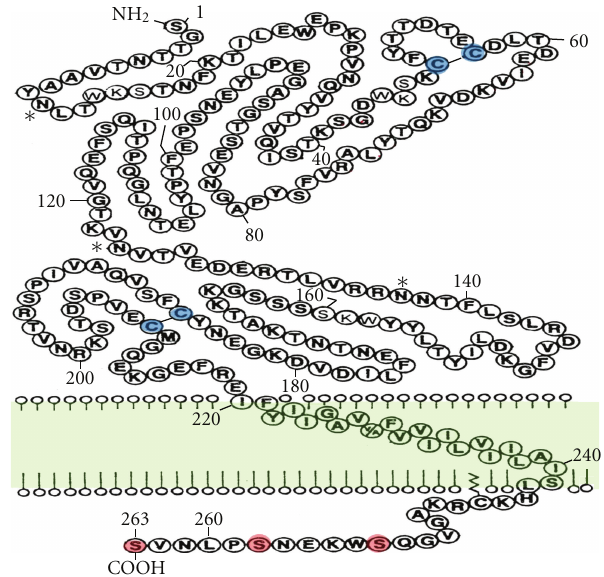
Figure 1: TF structure. The 46-kDa membrane-bound single polypeptide chain consists of extracellular, transmembrane, and cytoplasmic domains. There are 2 intrachain disulfide bridges (Cys49-Cys57 and Cys186-Cys209, shown in blue) in the extracellu- lar domain where it also contains FVII/FVIIa binding domain (see text) initiating signaling cascade for the extrinsic blood coagulation (Figure 2, left panel). There are three serine residues (shown in red) in the cytoplasmic domain for undergoing phosphorylation. ∗ Denotes 3 proposed glycosylation sites at Asn11, 124, and 137. Adopted and modified from